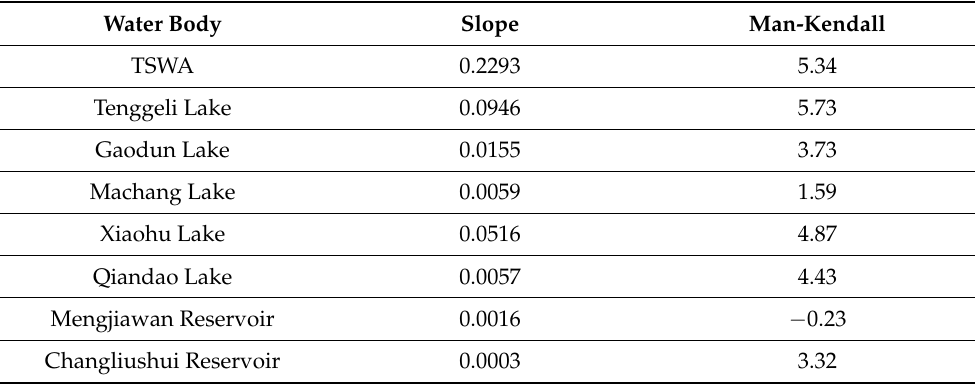
Table 7. Results of Trend Slope